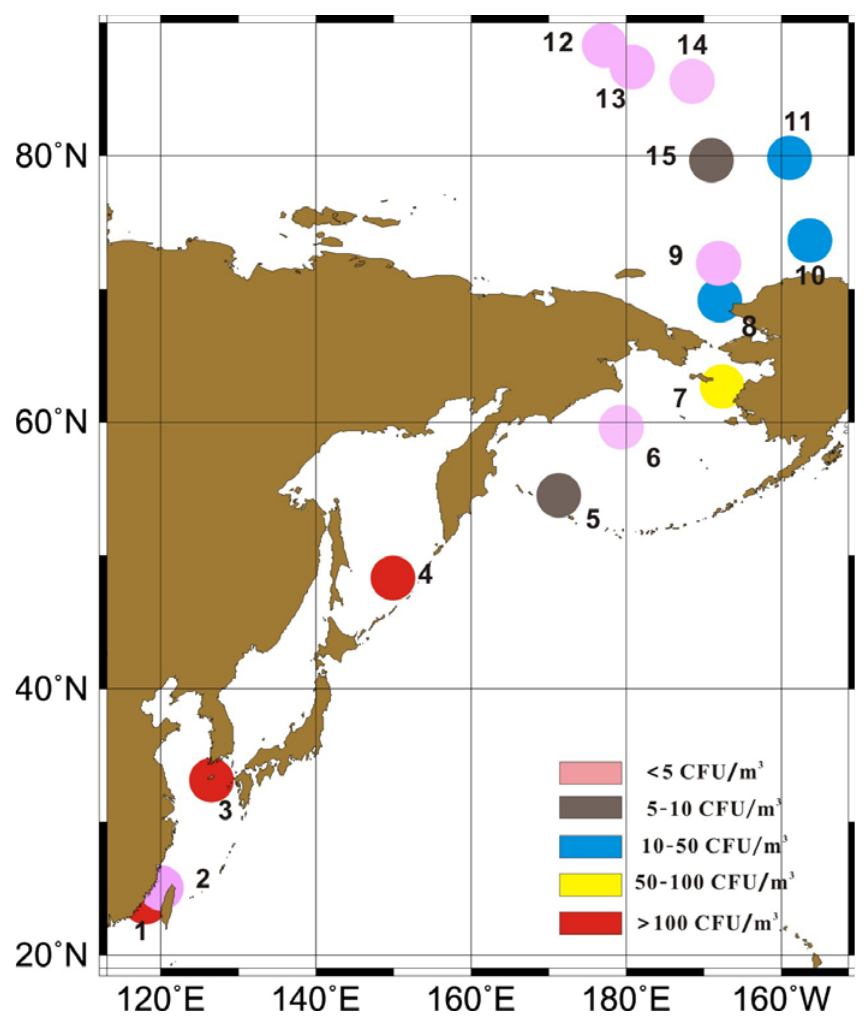
Figure 1. Concentrations of airborne fungi in the marine boundary layer during the CHINARE 2010.